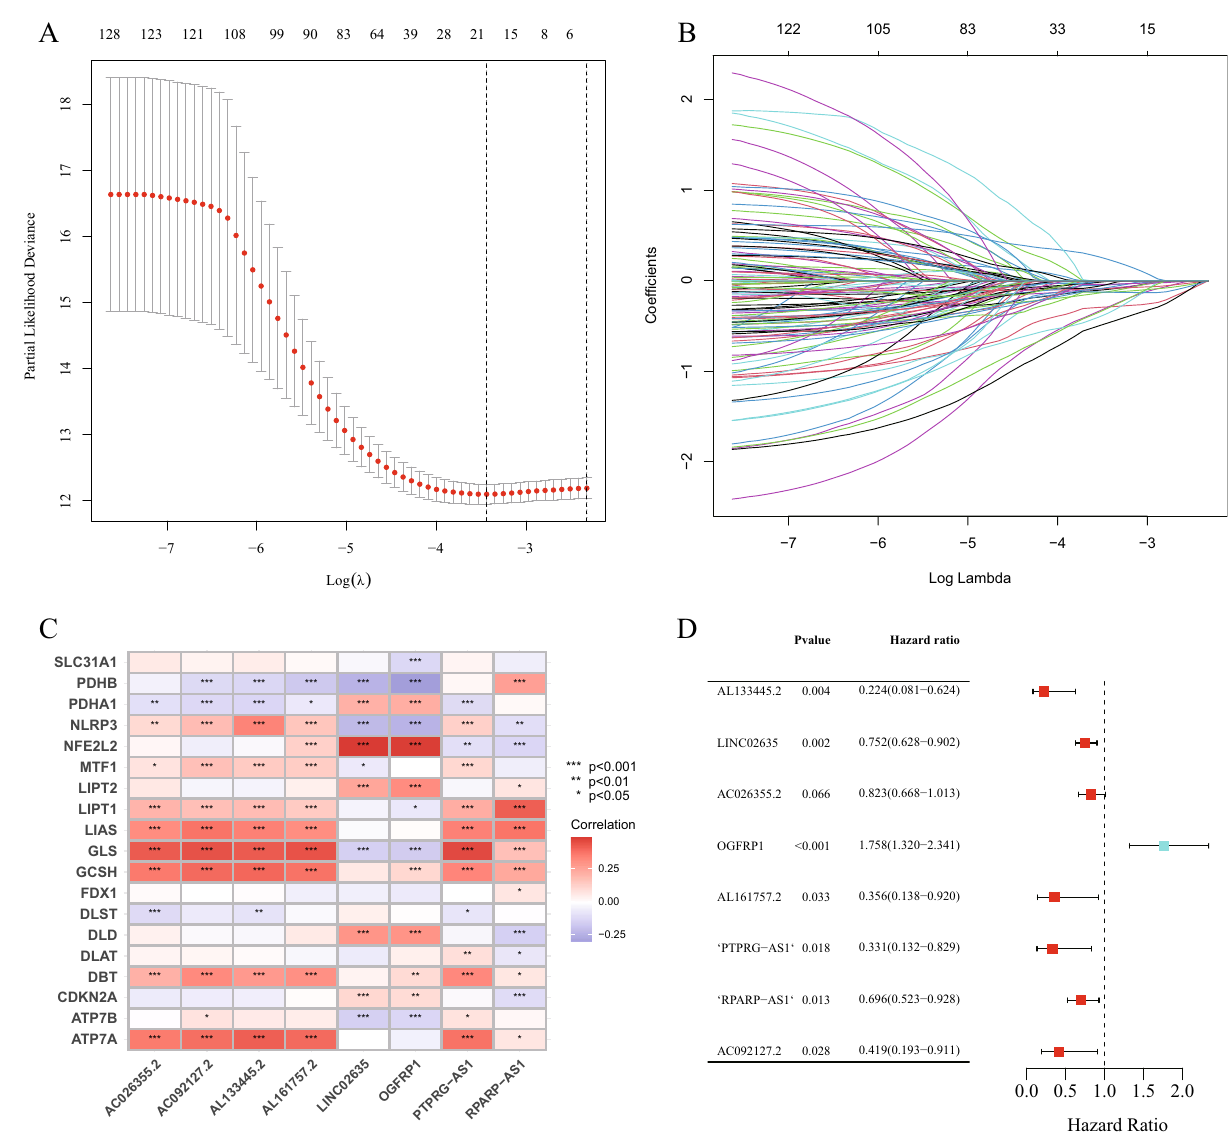
Figure 2. Construction of the cuproptosis-related lncRNA signature. ( A ) Confidence intervals are displayed for each lambda. ( B ) Partial likelihood deviation for various variable counts. The independent variable’s coefficient is represented by the vertical axis, while the independent variable’s log value is represented by the horizontal axis. ( C ) Correlations between signature lncRNAs and cuproptosis-related genes. ( D ) Multivariate Cox regression analysis of 8 signature lncRNAs. lncRNA, long non-coding formed to extract cuproptosis-related lncRNAs based on the threshold (coefficient > 0.4 and P < 0.001). Finally, a total of 1138 lncRNAs were associated with cuproptosis and were determined to be cuproptosis-related lncRNAs (Fig. 1, Table S1). The clinical data of 1002 patients with lung cancer were downloaded from TCGA as an entire set to identify the cuproptosis-related lncRNAs that were associated with patient prognosis. The clinical characteristics of these 1002 samples are shown in Table 1. Subsequently, the entire set (n = 1002) was randomly divided into a training set (n = 501) and a validation set (n = 501). Univariate analysis was performed on the training set, which determined that 133 cuproptosis-related lncRNAs were significantly associated with the prognosis of patients with lung cancer (P < 0.05, Fig. S1, Table S2). To minimize the error rate, LASSO analysis and multi- variate analysis were performed. Finally, 8 cuproptosis-related prognostic lncRNAs were extracted (Fig. 2A,B). In multivariate Cox regression analysis, the risk score was created by linearly combining the expression lev- els of the 8 cuproptosis-related prognostic lncRNAs, weighted by their relative coefficient (Fig. 2D, Table 2) as follows: Risk score = (− 1.495239459 * AL133445.2) + (− 0.284516815 * LINC02635) + (− 0.195045442 * AC026355.2) + (0.563925195 * OGFRP1) + (− 1.031936125 * AL161757.2) + (− 1.105927746 * PTPRG- AS1) + (− 0.361962738 * RPARP-AS1) + (− 0.868805559 * AC092127.2). Figure 2C shows the relationships between the 19 cuproptosis genes and 8 cuproptosis-related prognostic lncRNAs.